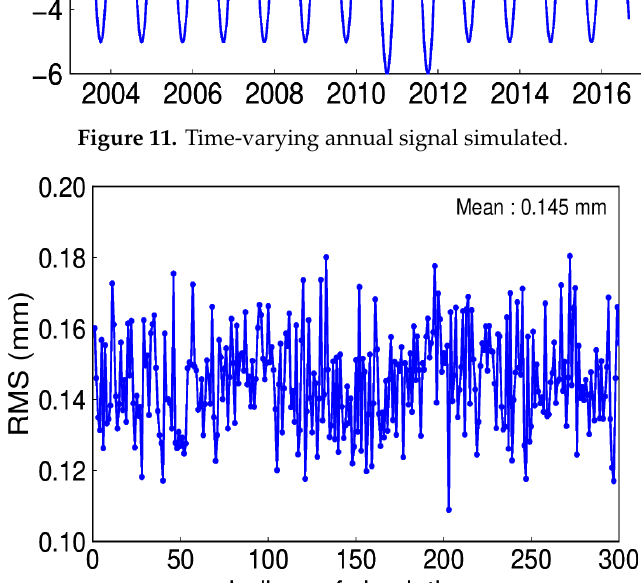
Figure 12. The minimum RMS with the optimal Independent Points (IPs).